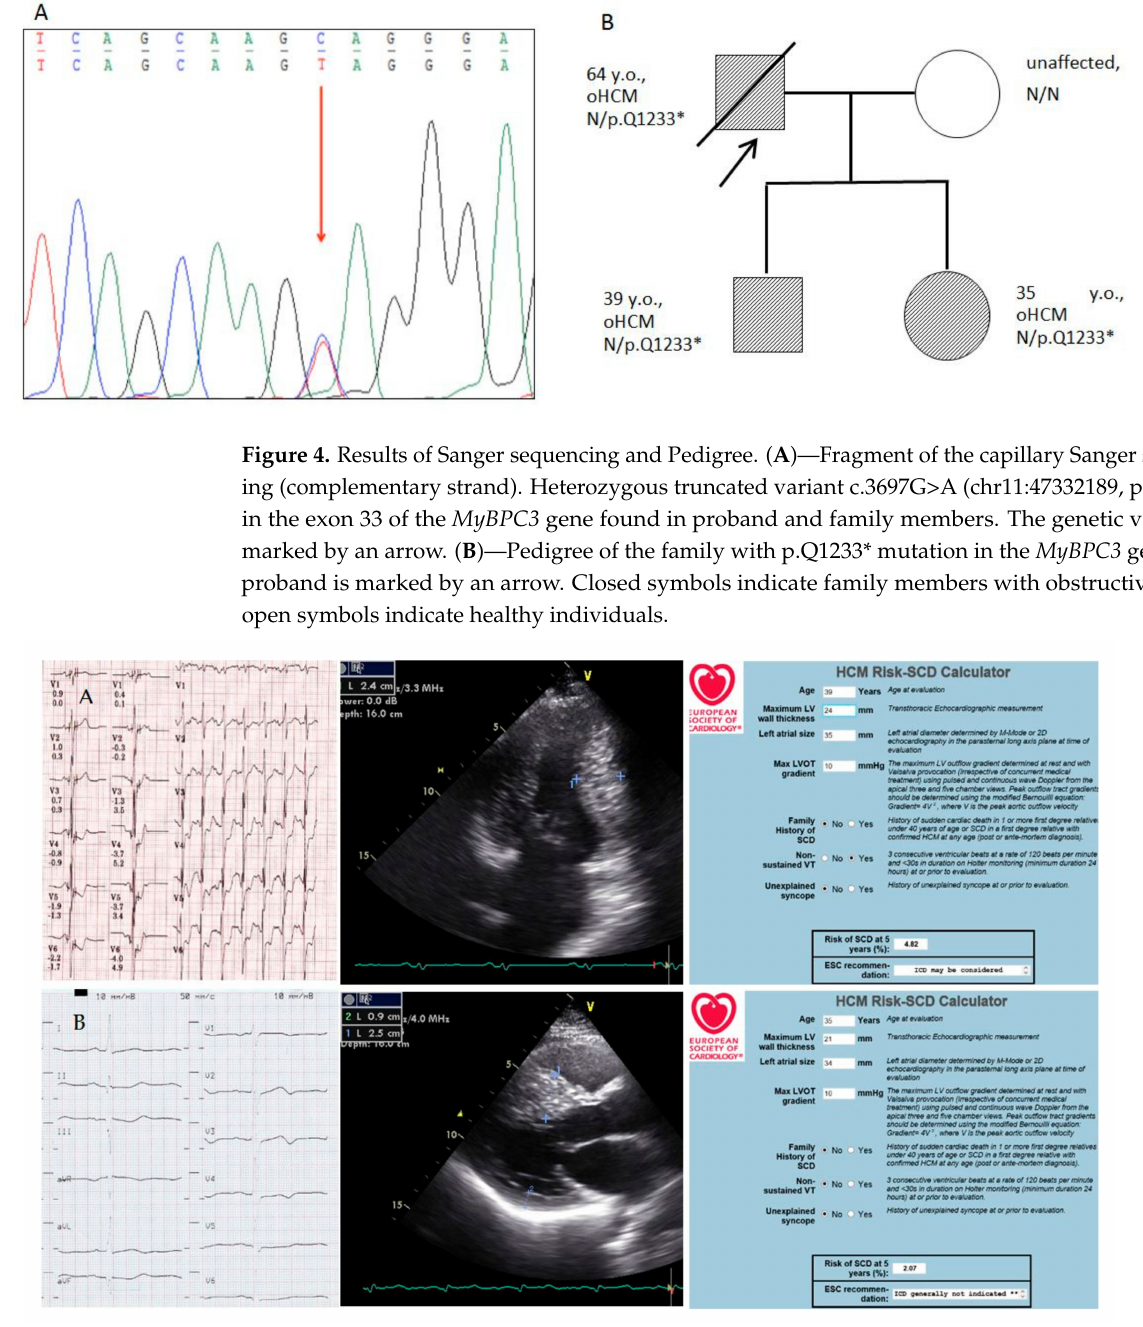
Figure 5. The patient’s children’s examinations (( A )—39-year-old son, ( B )—35-year-old daughter). ECG (paper speed is 25 mm/s); ultrasound cardiography (measurements of interventricular septum thickness); calculation of the risk of sudden cardiac death. Explanations in the